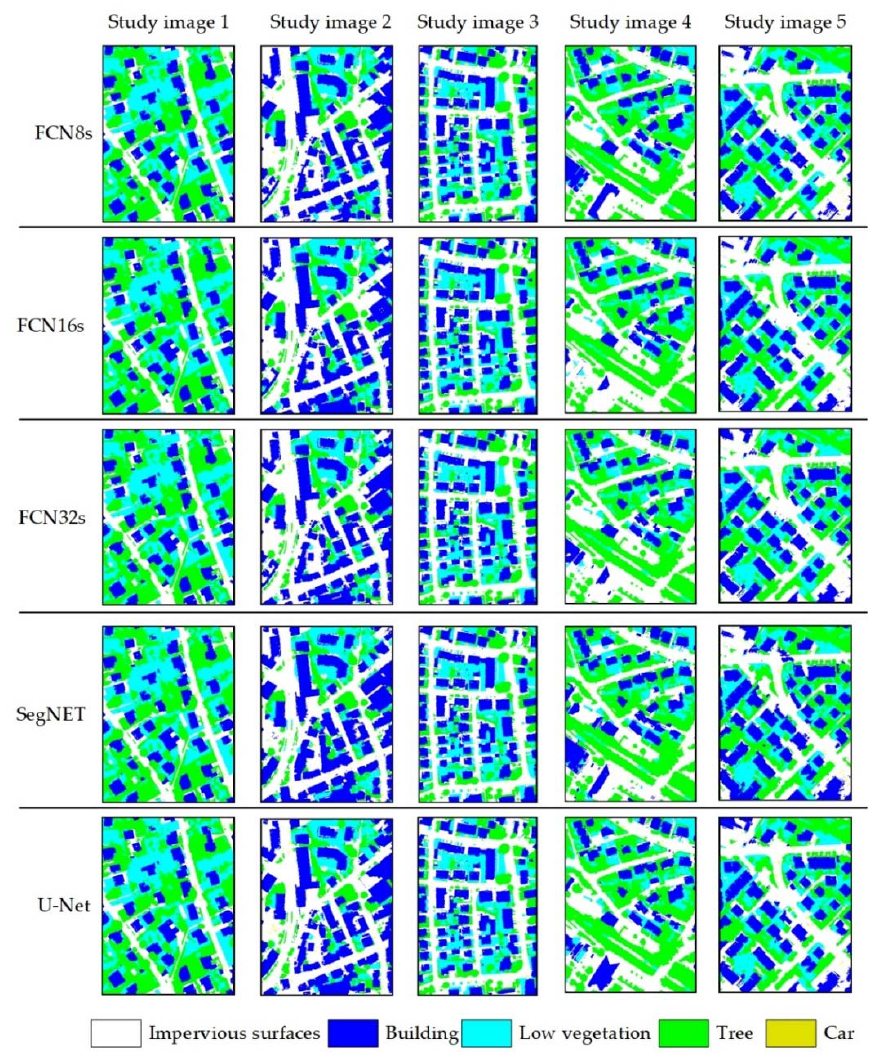
Figure 9. ELP correction results.